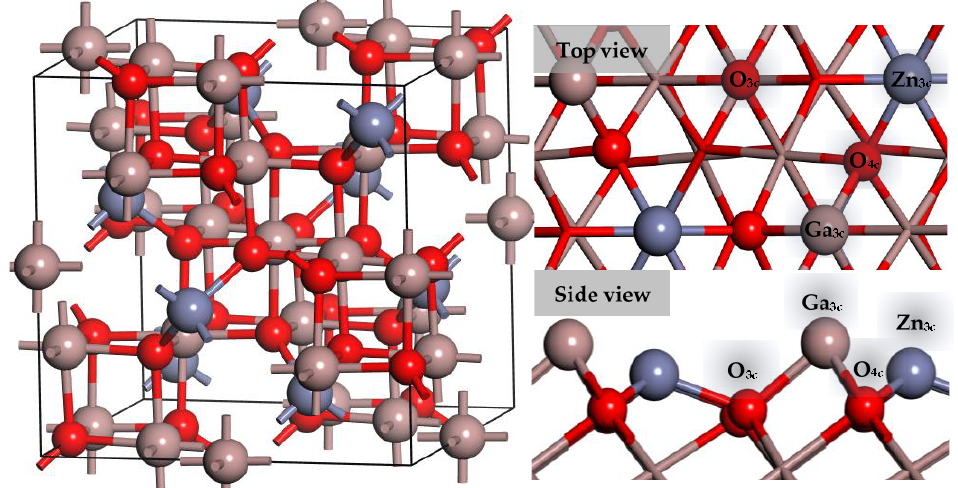
Figure 1. The bulk ZnGa 2 O 4 crystal and top and side views of the ZnGa 2 O 4 (111) surface. Surface atoms are labeled Ga 3 c , Zn 3 c , O 3 c , and O 4 c . Atoms are represented by spheres: Zn (gray, large), Ga (brown, medium-sized), and O (red, small).